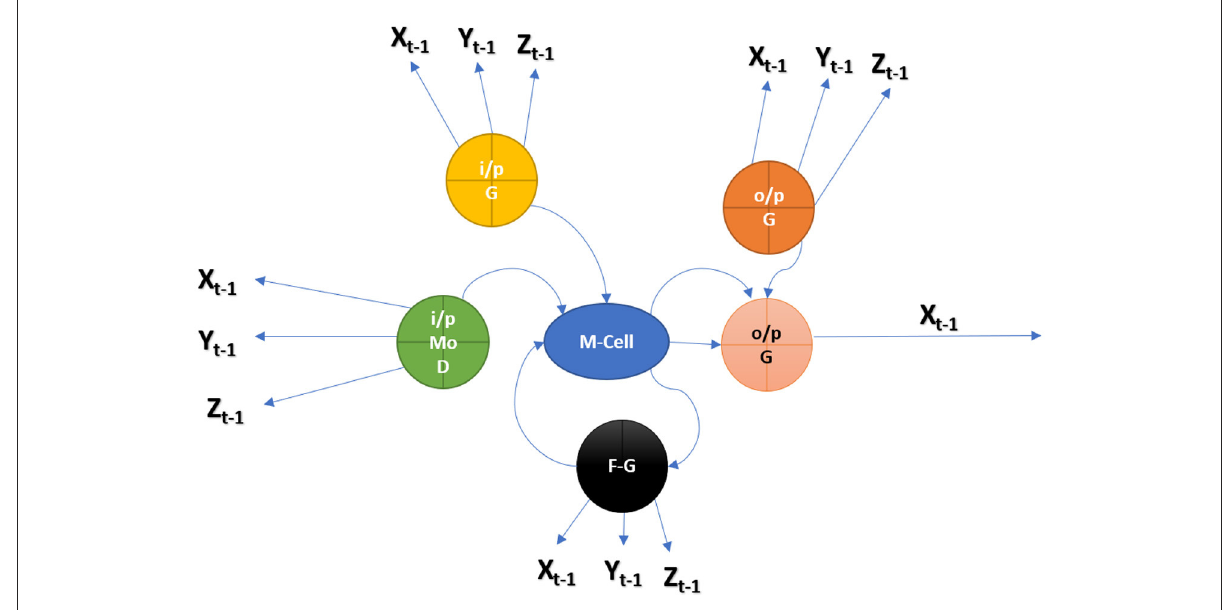
FIGURE1 Cell format of LSTEM.